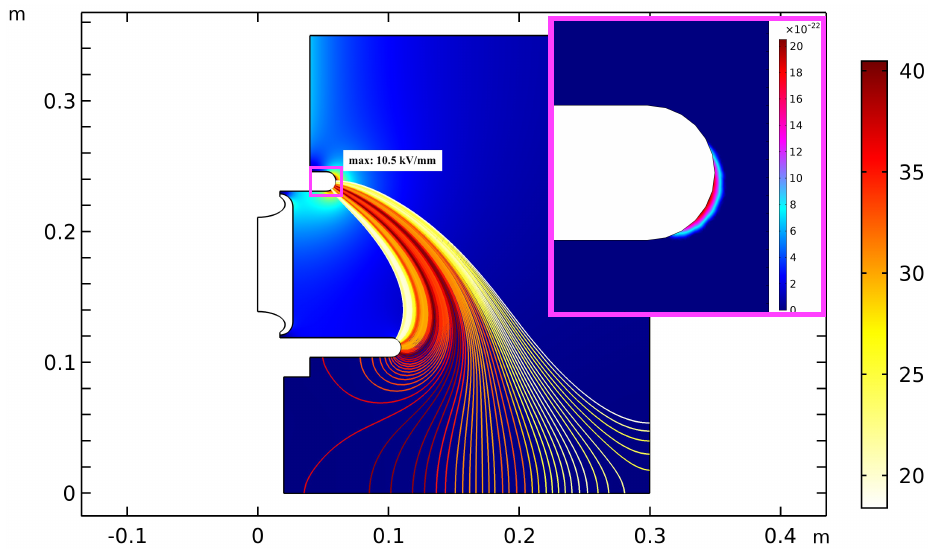
Figure 7. Streamer integrals (15) satisfying streamer criterion for discharges originating from high voltage electrode. The peak value of simulated electric field is above the breakdown electric field of SF 6 of 8.9 kV/mm at 0.1 MPa. The inset detail shows the region where ¯ α > 0 in proximity of the high voltage